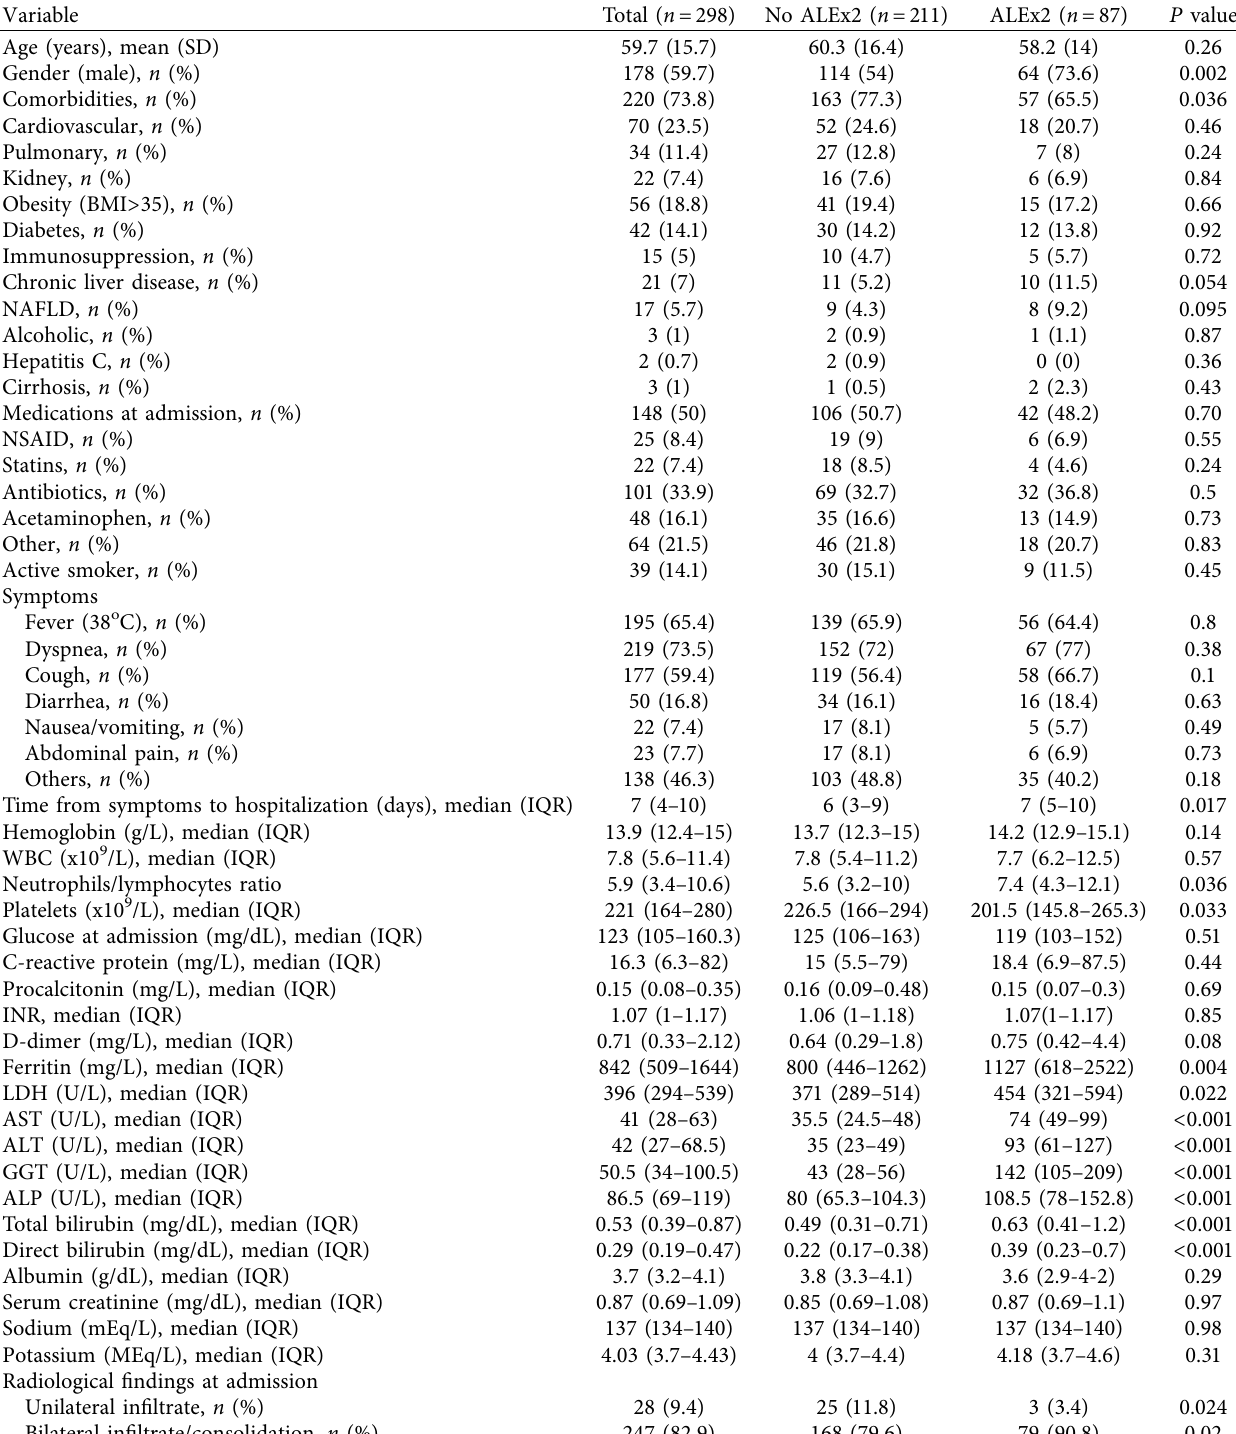
Table 1: Clinical and laboratory characteristics of patients hospitalized for COVID-19 at the moment of admission.